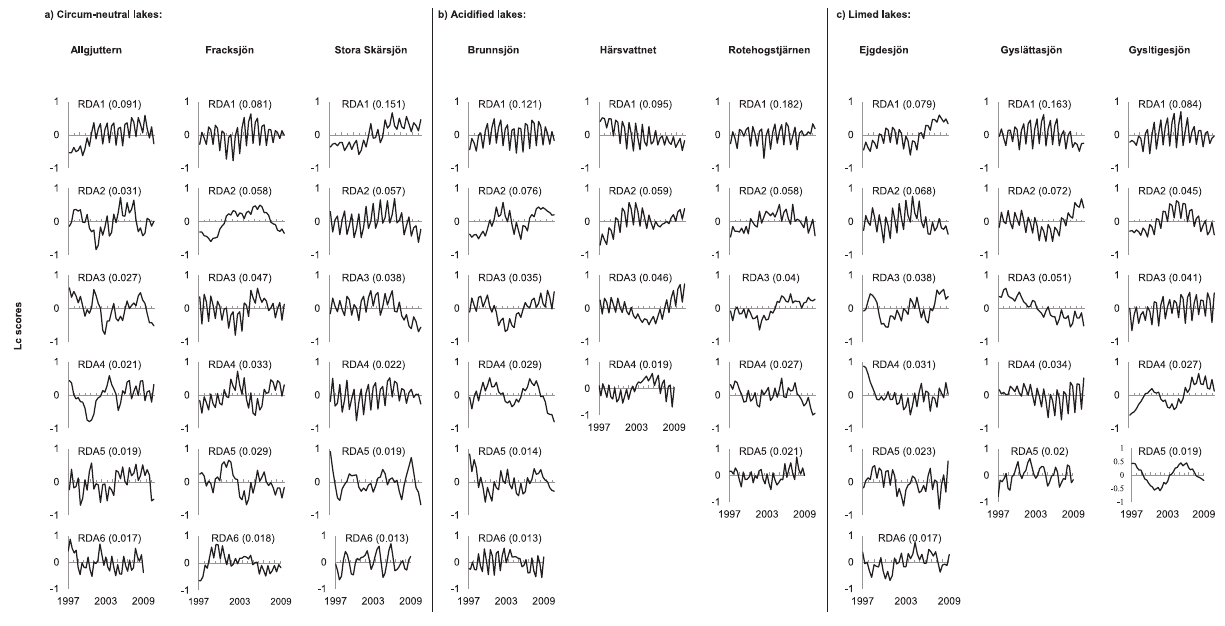
Figure 3. Lc score plot showing the temporal patterns of individual significant canonical with corresponding constrained variance for (a) circum-neutral lakes, (b) acidified lakes and (c) limed lakes.